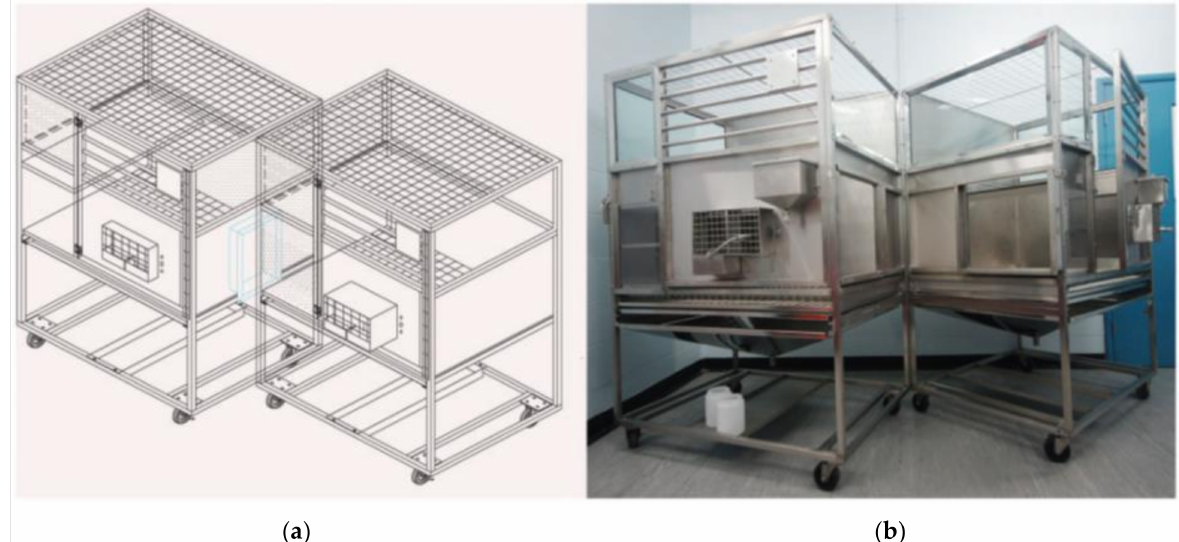
Figure 1. Schematic ( a ) and photo representation ( b ) of the dual cage system with a hatch between the two connected cages for pair-housed